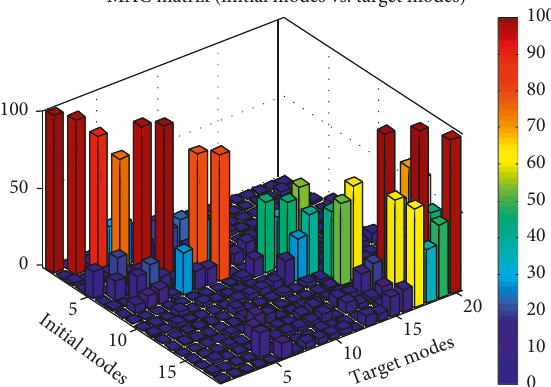
Figure 31: MAC of configuration 1 initial-target model.